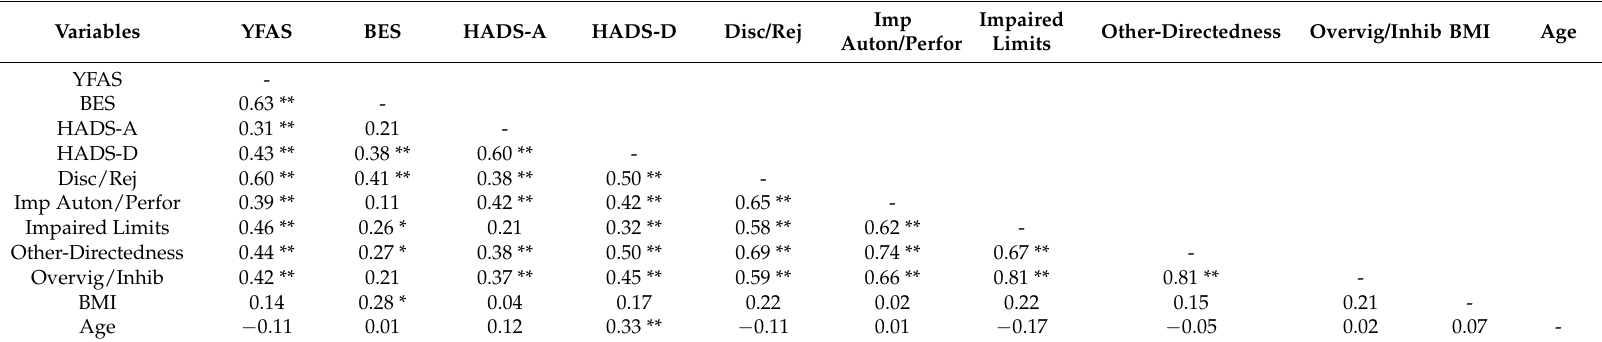
Table 2. Values of Pearson’s r correlation coefficient among variables in all samples ( N = 70). Significant correlations are indicated by stars (*).